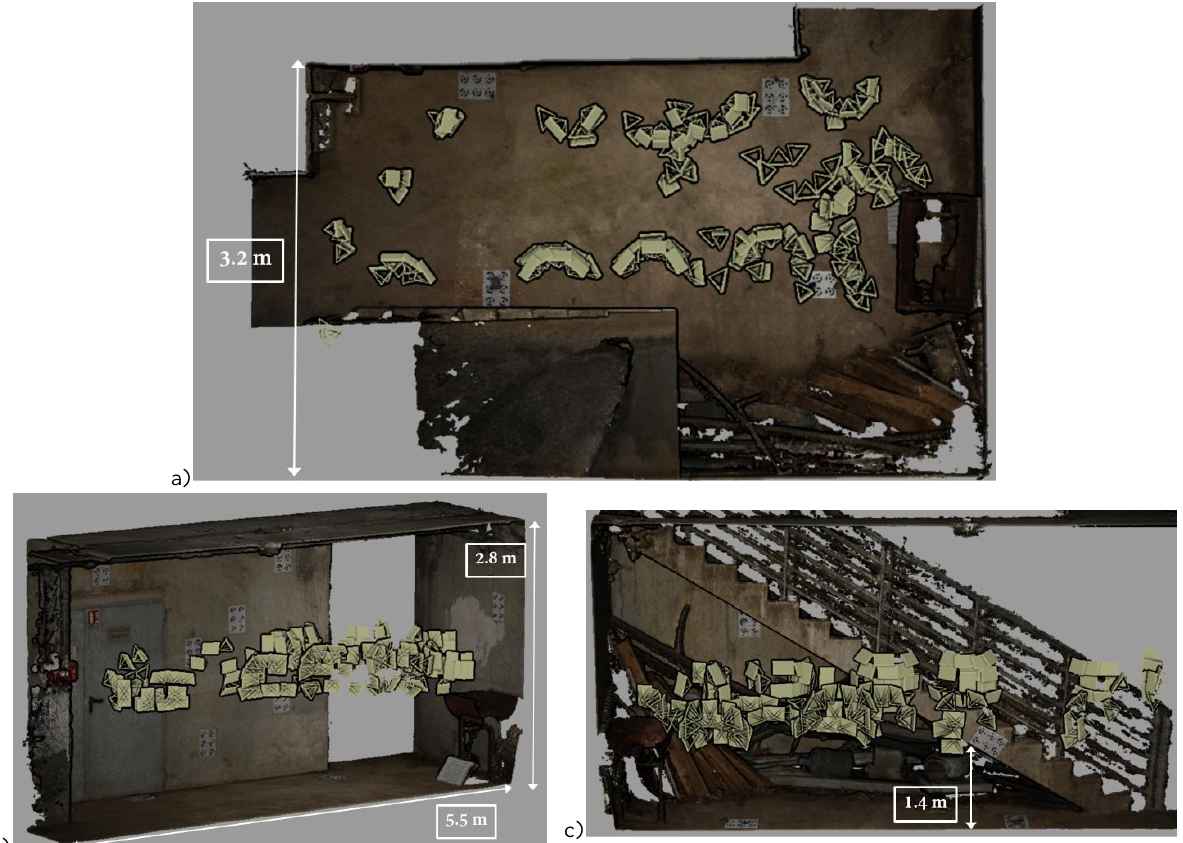
Figure 3. Top (a) and later views (b, c) of the test area with the reference camera